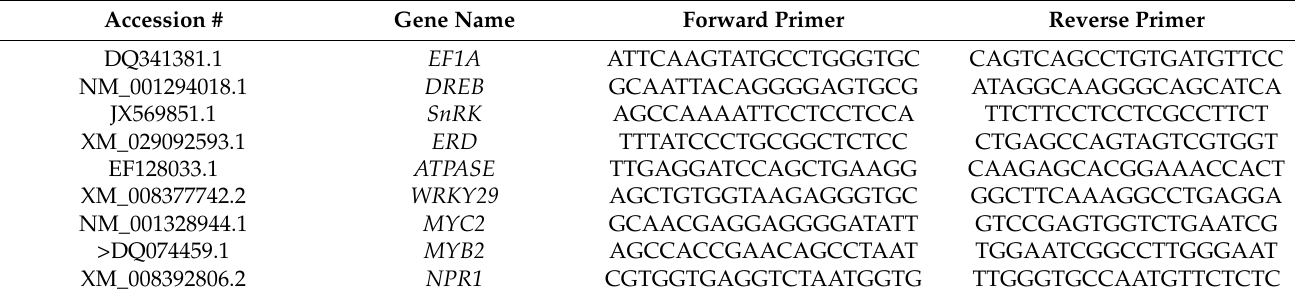
Table 1. List of the used primers of osmotic responsive genes in apple ( Mulas domestica